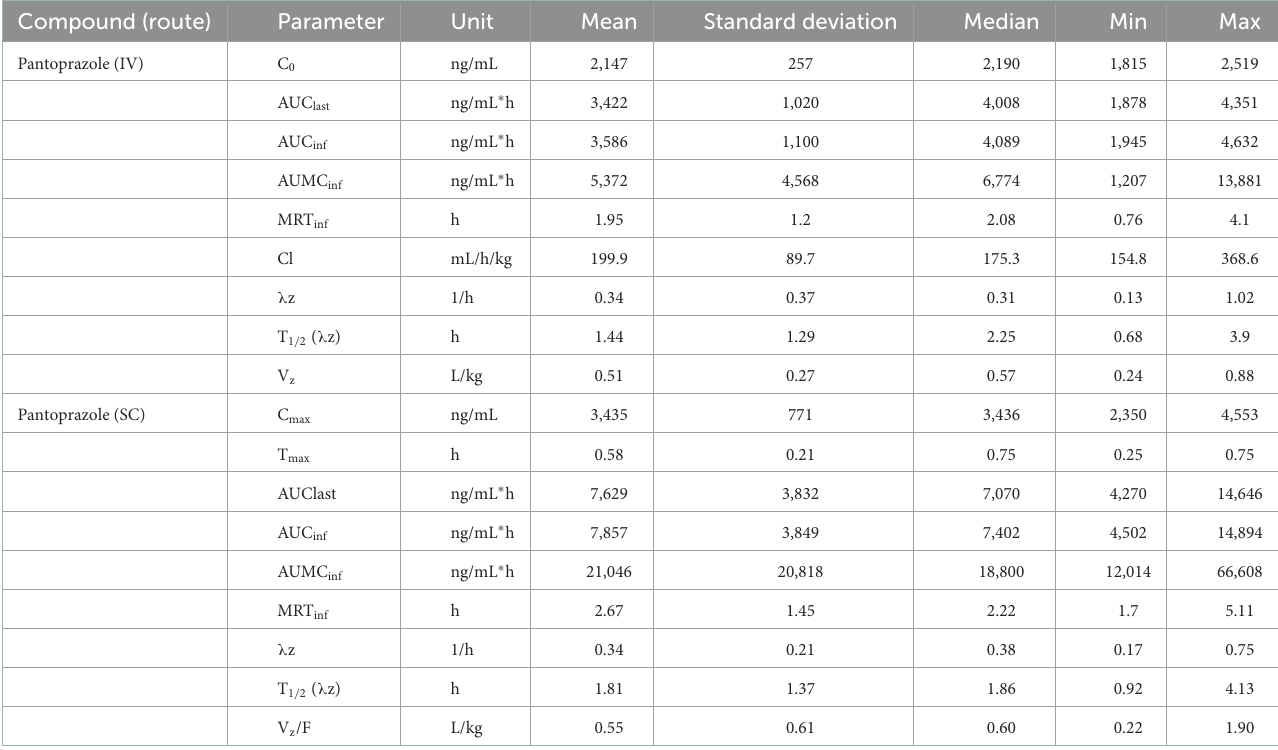
TABLE 1 Day 1 pharmacokinetic parameters of pantoprazole after intravenous (IV) and subcutaneous (SC) administration in calves. Compound (route)